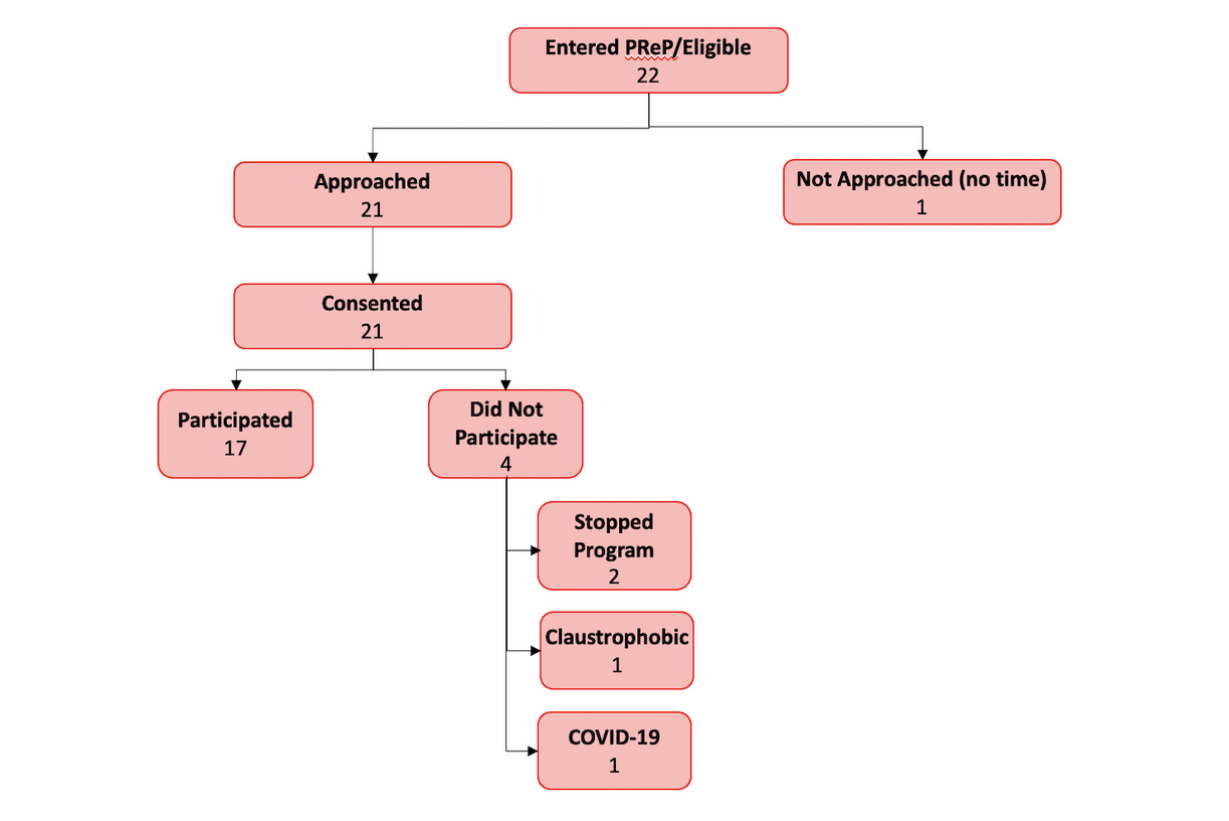
Figure 2. Virtual reality CONSORT